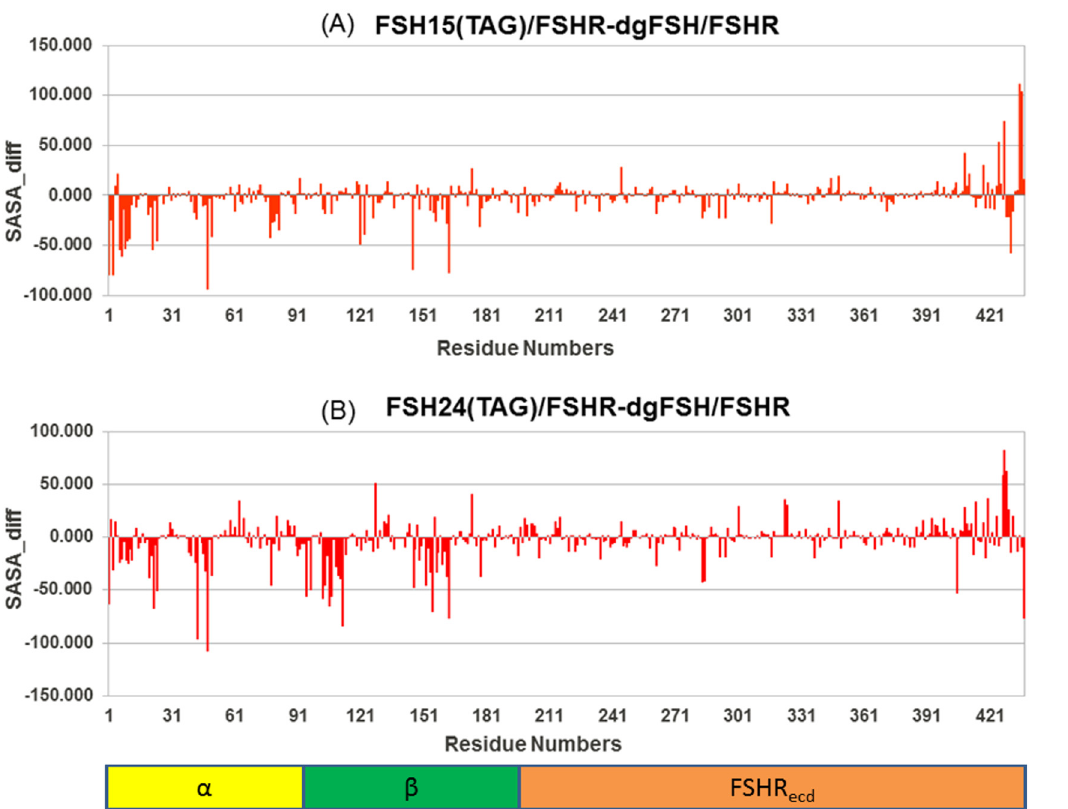
Fig 14. Difference in Solvent Accessible Surface Area (SASA) for FSH 15 (TAG)-FSHR and FSH 24 (TAG)-FSHR from